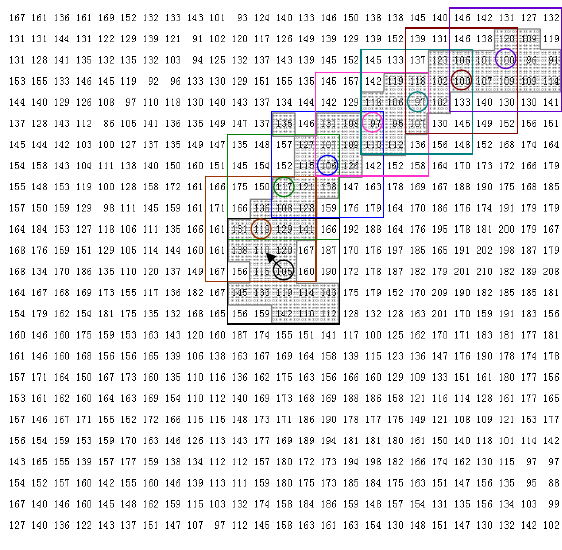
Figure 6. K-means clustering and directional region growing in the sliding window